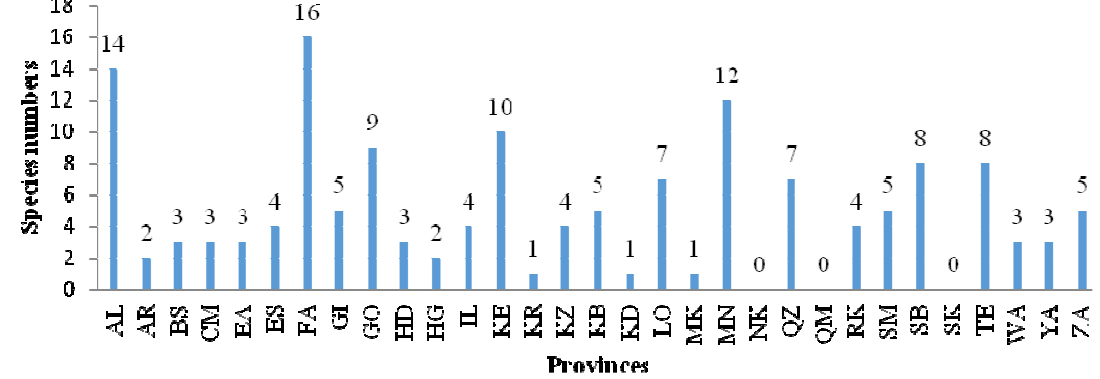
F IGURE 3. Frequency species of subfamily Galerucinae s. str. in all provinces of Iran D